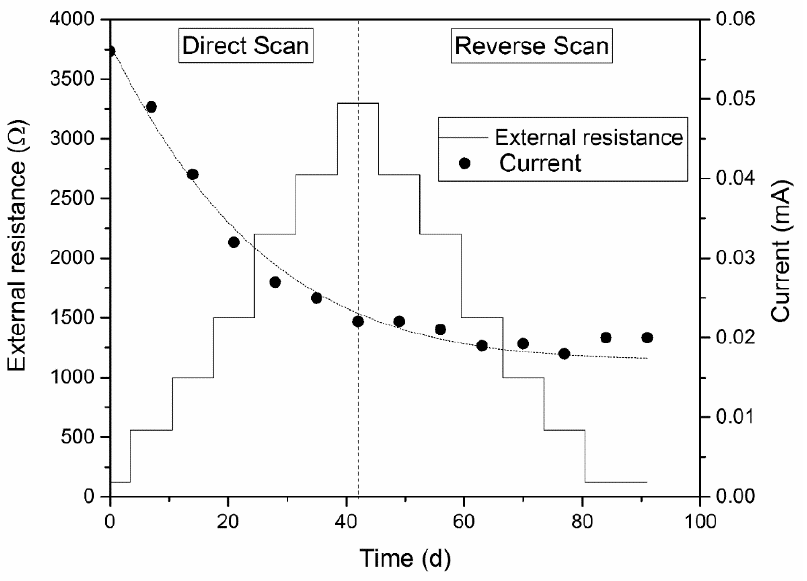
Figure 2. Current exerted by the microbial fuel cells (MFC) at every external resistance.